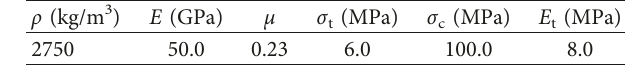
Table 2: Rock mass physical and mechanical